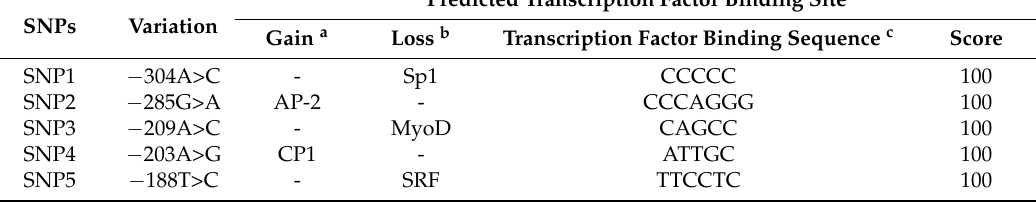
Table 2. In silico alteration of nucleotides to generate alternative SNP alleles, resulting in putative gain or loss of transcription factor binding sites.